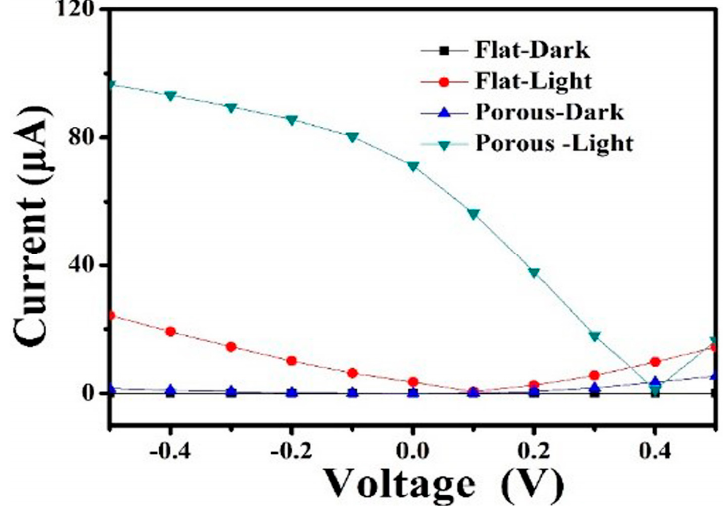
Figure 7. I–V curves of CoPc / porous-GaN- and CoPc / flat-GaN-based UV PDs.